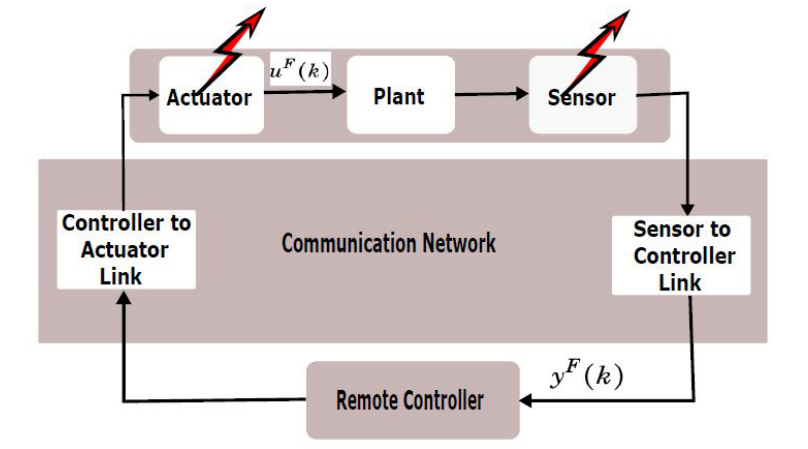
Figure 2. Control over communication